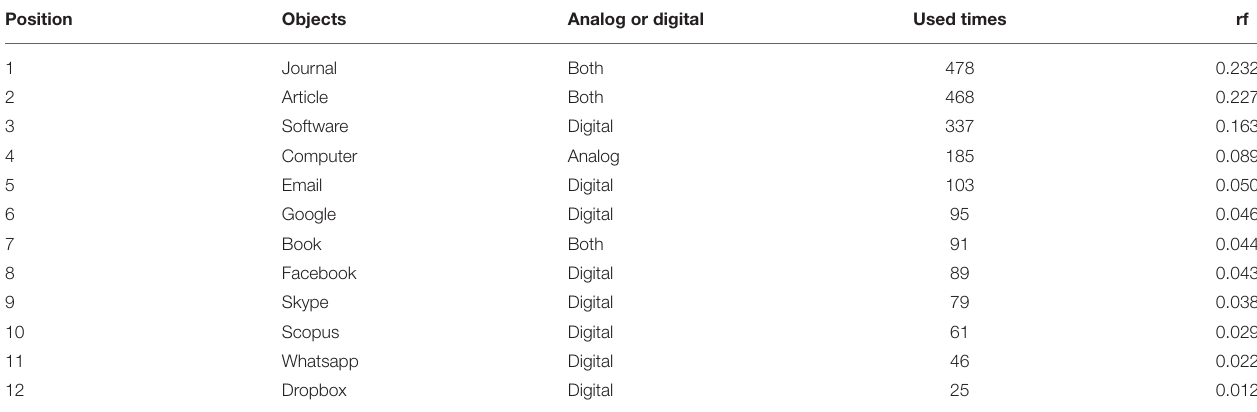
TABLE 3 | Twelve most frequent objects shared by researchers.